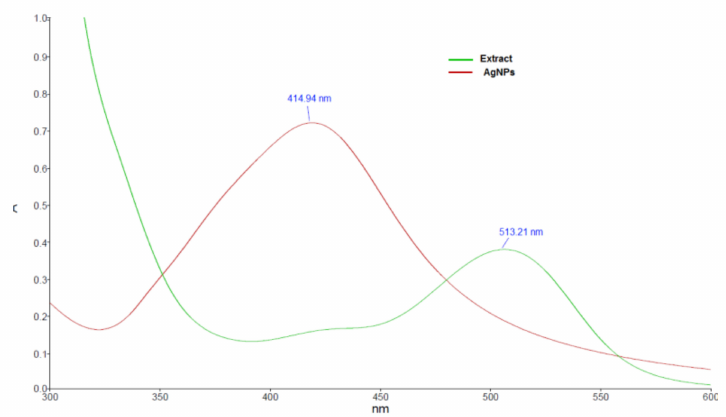
Figure 2. UV-Vis spectra of fruit extract and obtained silver